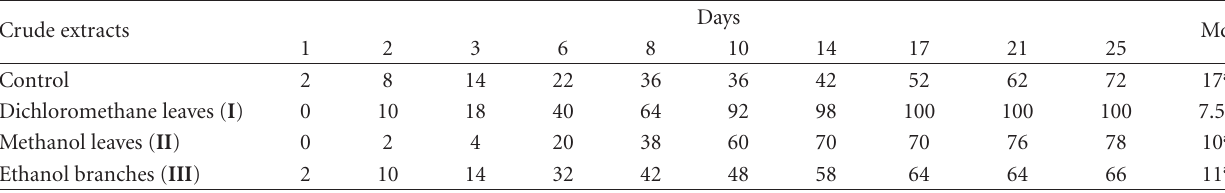
Table 1: A. sexdens rubropilosa workers mortality (%) and survival median (Md) when fed with diet containing crude extracts (2000 μ g · mL − 1 ) from V. sebifera .